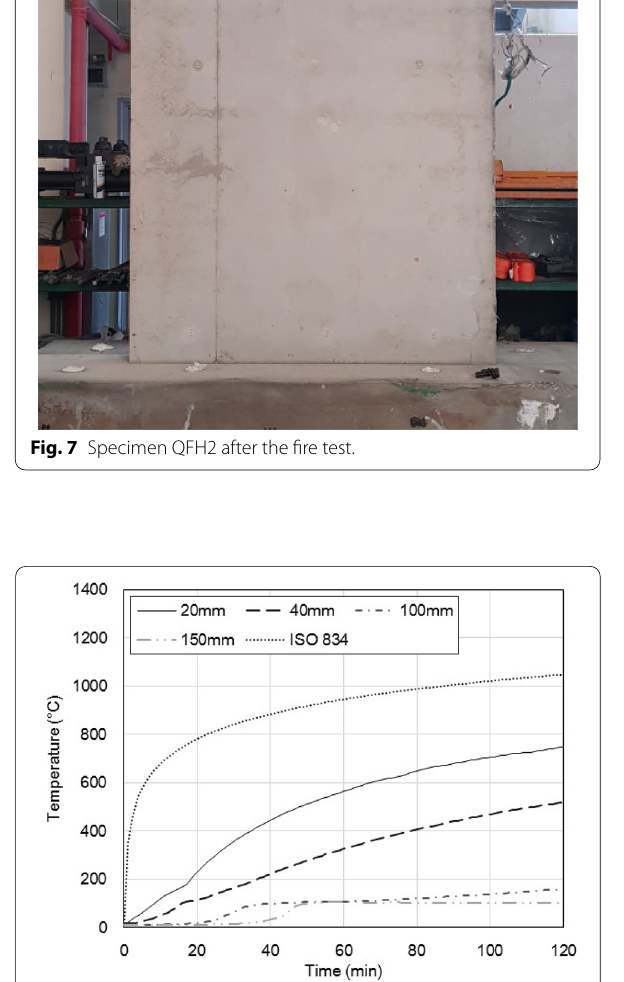
Fig. 8 The time–temperature curve at different depth of the specimen